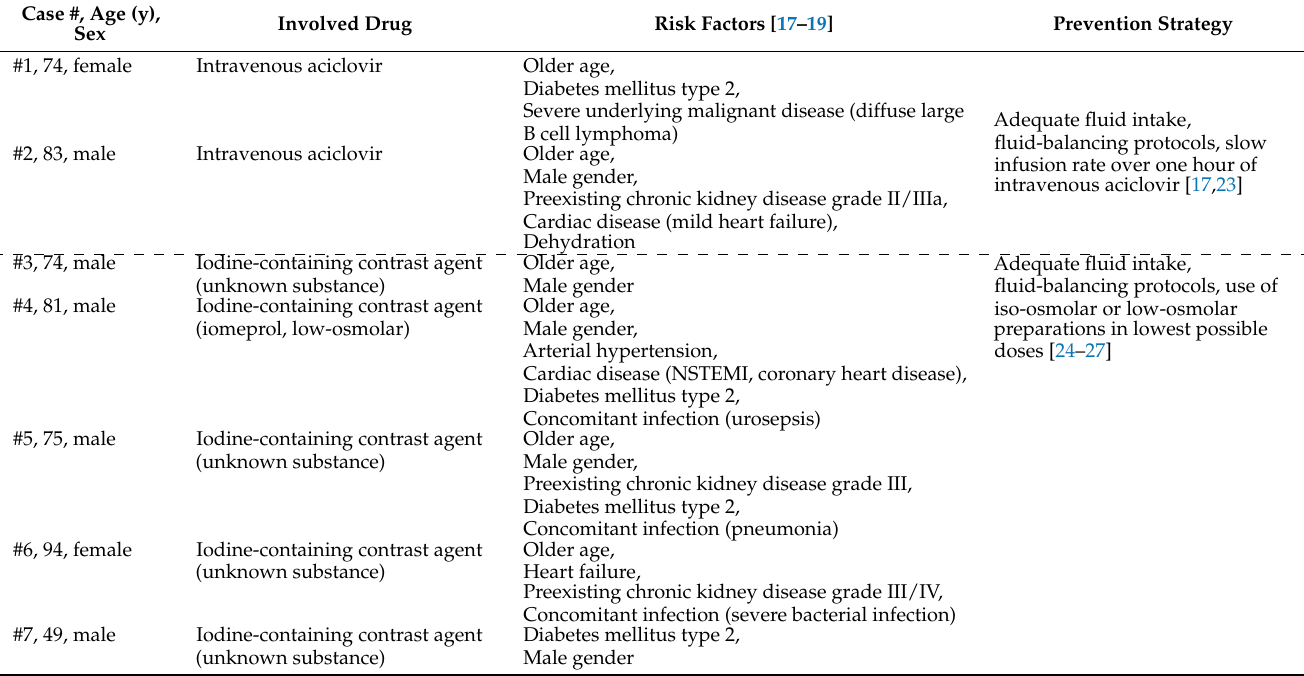
Table 3. Inpatient cases with potentially preventable ADE for whom possible prevention strategies could be